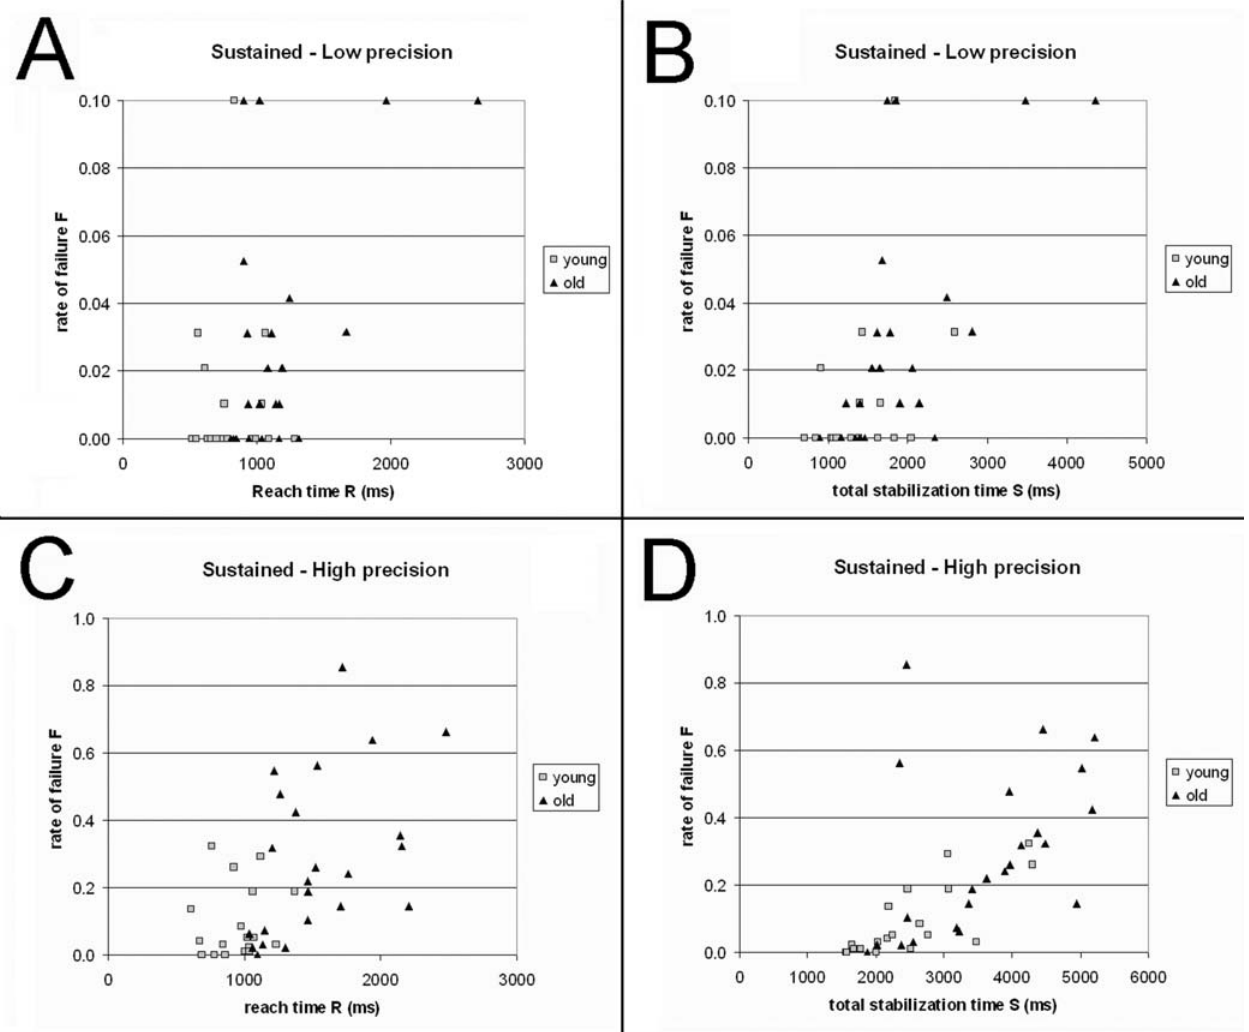
Figure 4. Scatter plot of performance for the sustained modality. Each dot represents the performance of one participant. Black triangles : old participants. Grey squares : young participants. The triangles that are in the middle of the group of squares represent old participants whose performance is indistinguishable from that of young people. Vertical : rate of failure F. Horizontal : time (ms). A : low precision, reach time R vs. F. B : low precision, total stabilization time S vs. F. C : high precision, reach time R vs. F. D: high precision, total stabilization time S vs. F. Note that the vertical axes of the graphs differ given the different ranges of rate of failure in low and high precision conditions. In addition, in A , B , the rate of failure is bounded to 0.1 for